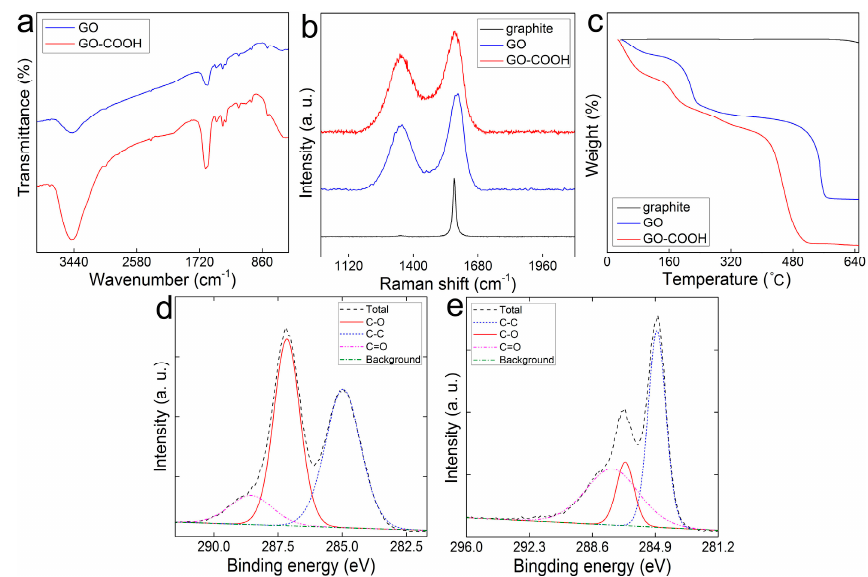
Figure 2. Characterization of graphite, GO sponge and GO-COOH sponge. ( a ) IR spectra; ( b ) Raman spectra; ( c ) TGA data; (D&E) C1s XPS spectra of GO sponge ( d ) and GO-COOH sponge ( e ).